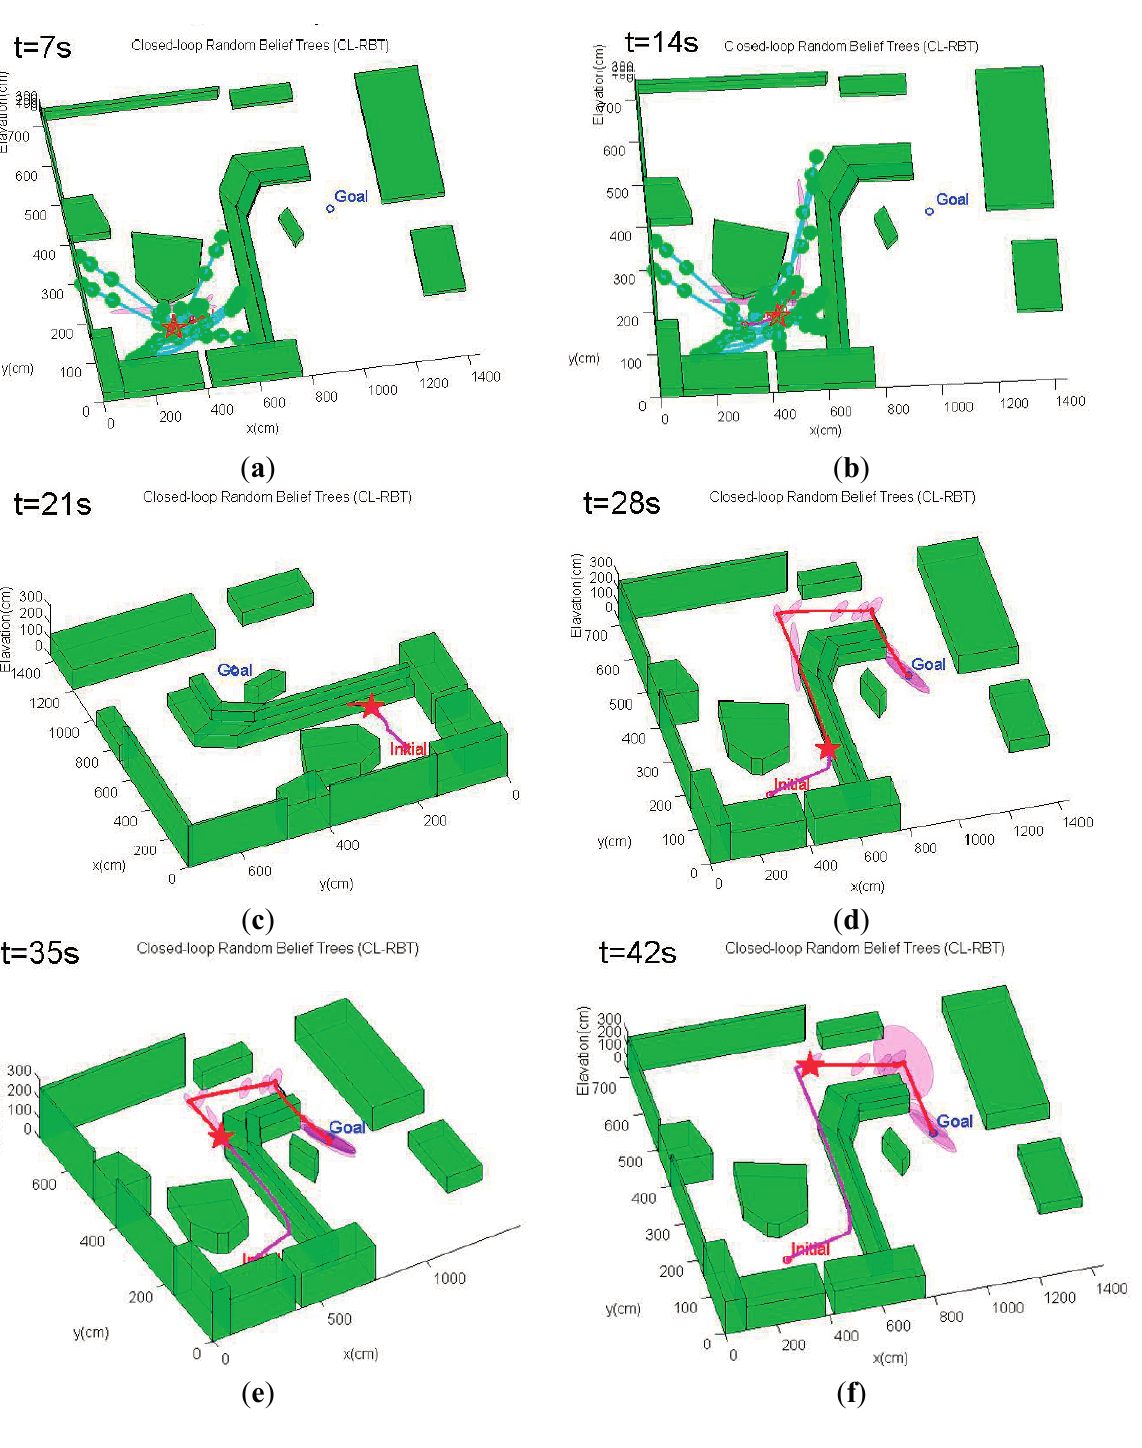
Figure 11. Example results of the trajectory generated by the CL-RBT for a quadrotor MAV navigating in a cluttered environment. The full legend for the symbols can be found in Figure 8. The current tree is set as invisible after ( b ) for clarity. ( a ) t = 7 s; ( b ) t = 14 s; ( c ) t = 21